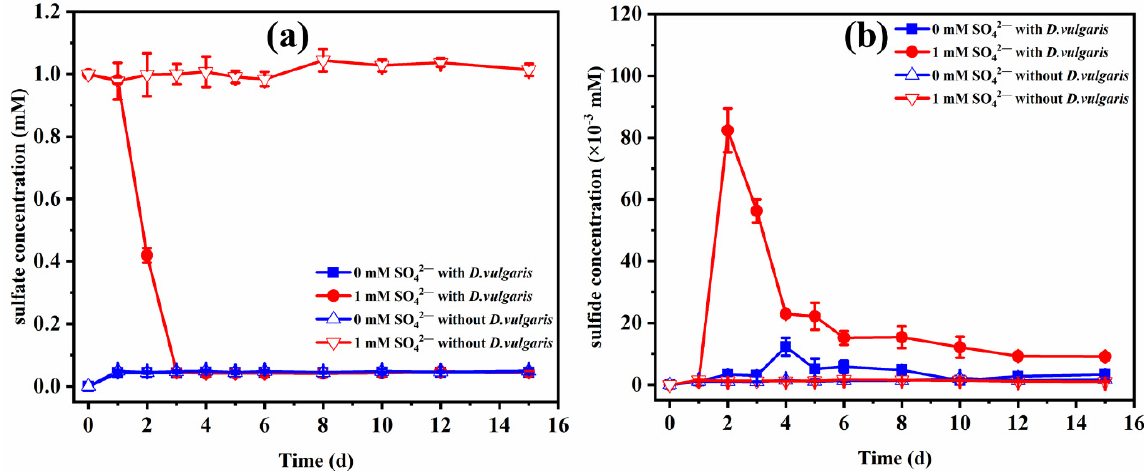
Figure 8. The changes of sulfate ( a ) and sulfide ( b ) concentrations during sediment experiment. Error bars indicate standard deviation of triplicates.